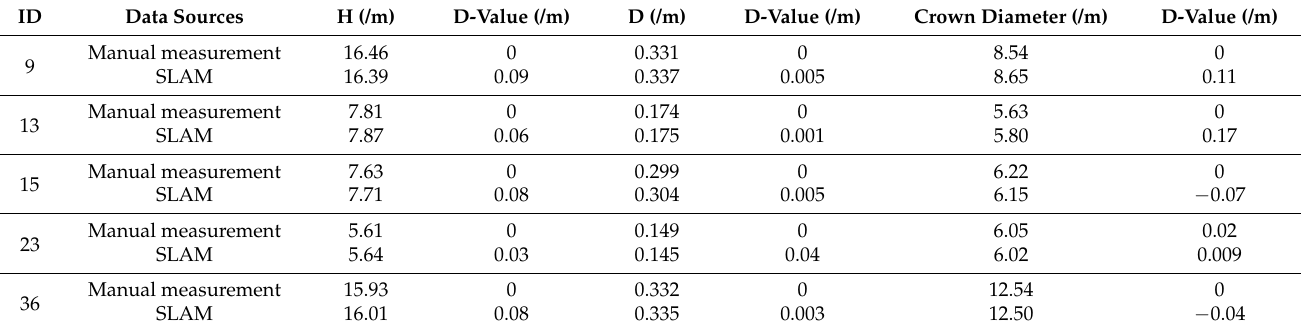
Table 2. Comparison of different parameters extracted by different methods from the same wood.